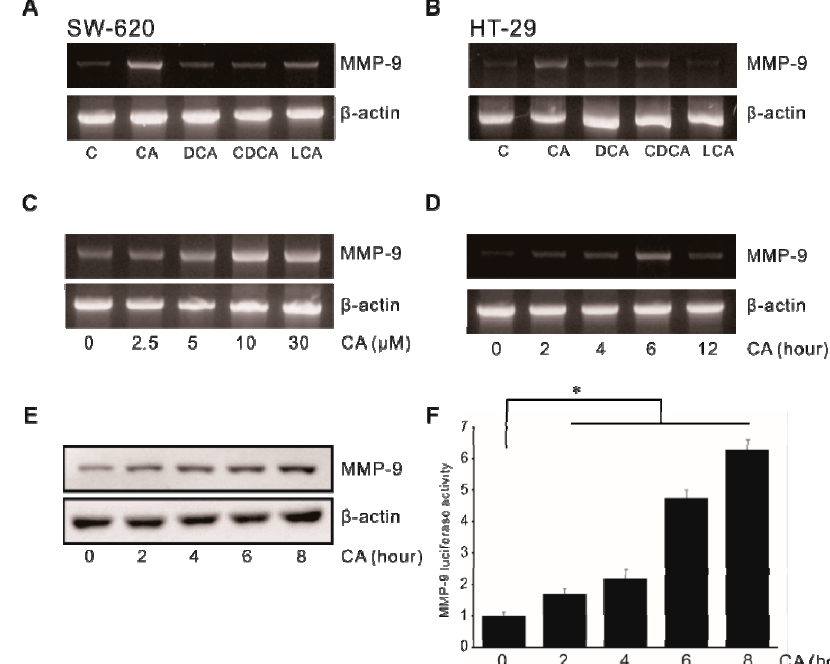
Figure 1. E ff ect of bile acid on matrix metalloproteinase-9 (MMP-9) expression in colon cancer cells. SW620 cells ( A ) and HT29 cells ( B ) were treated with four di ff erent bile acids at 30 µ M for 4 h, followed by mRNA extraction and RT-PCR to determine MMP-9 expression level. SW620 cells were treated with cholic acid (CA) at 0–30 µ M for 4 h ( C ) or with 10 µ M CA for 0–12 h ( D ), followed by mRNA extraction and RT-PCR to determine MMP-9 expression level. ( E ) SW620 cells were treated with 10 µ M CA for 0–8 h, and cell lysates were used to determine MMP-9 protein expression using Western blot analysis. ( F ) SW620 cells were transiently transfected with 500 ng pGL4-MMP-9 promoter–reporter construct. These transfected cells were treated with 10 µ M CA for 0–8 h and the luciferase activity was determined using a luminometer. Data represent the mean ± standard deviation (SD) from triplicate measurements. * p < 0.05 versus control.